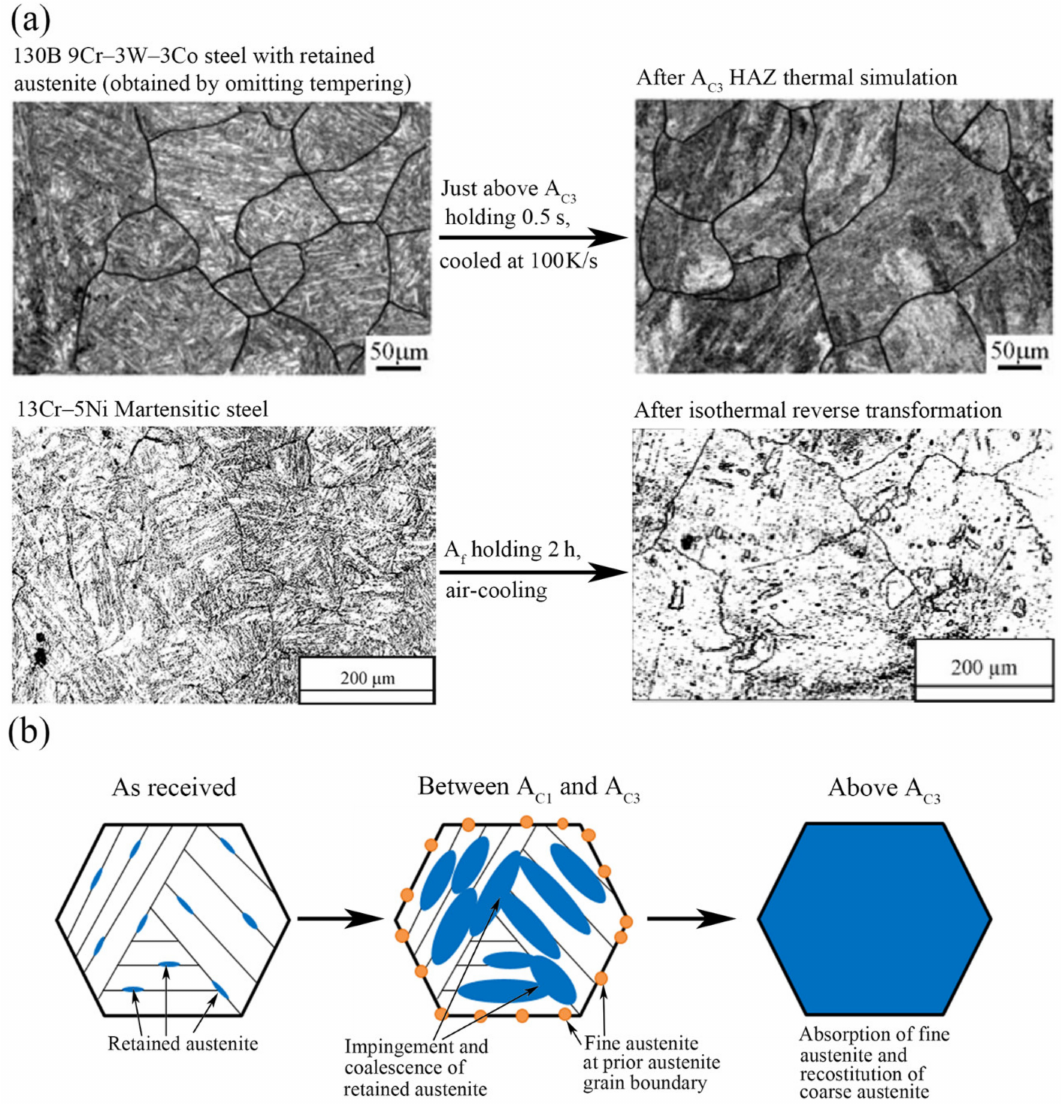
Figure 6. Austenite memory e ff ect in containing retained austenite martensitic steel: ( a ) SEM images of containing 1.9% retained austenite 130B 9Cr–3W–3Co steel [70] and 13Cr–5Ni martensitic steel [77] and ( b ) schematic diagram of mechanism of retained austenite growth and